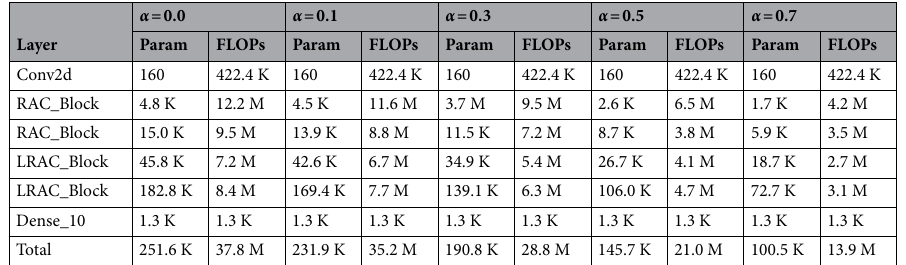
Table 2. The number of parameters and FLOPs of RACNN on UrbanSound8K under different α .